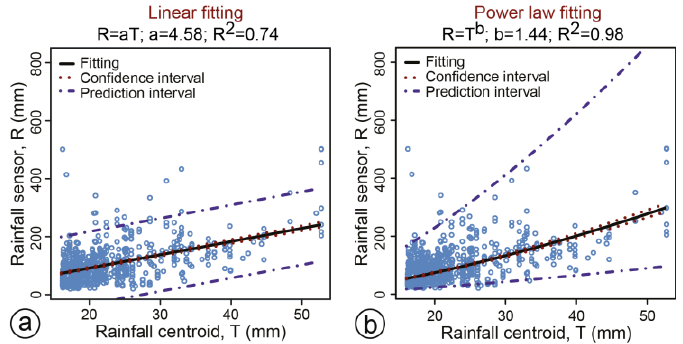
Figure 4. Linear ( a ) and power-law ( b ) fitting between TMPA-V6 rainfall estimates T and rain gauge measures R . The two regression examples are for the 72-h cumulative rainfall in the Alpine region (Alps, see Table 2 and Figure 1) filtered using a rainfall threshold of 16 mm. Solid black lines is the best fitting, dotted red and dot-dashed blue lines are the confidence and the prediction intervals respectively.